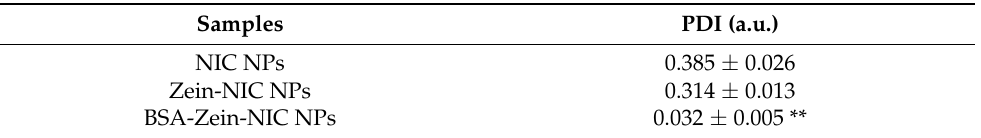
Table 1. Colloidal stability in terms of PDI values of various NPs in aqueous solution, namely NIC, Zein-NIC, and BSA-Zein-NIC. n = 3, ** p -value < 0.005.